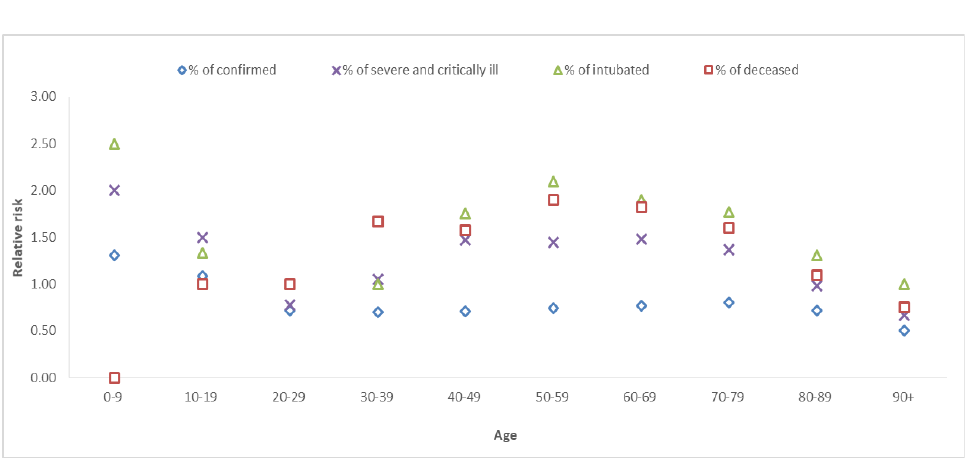
Table 2. Differences in vaccination uptake between males and females.